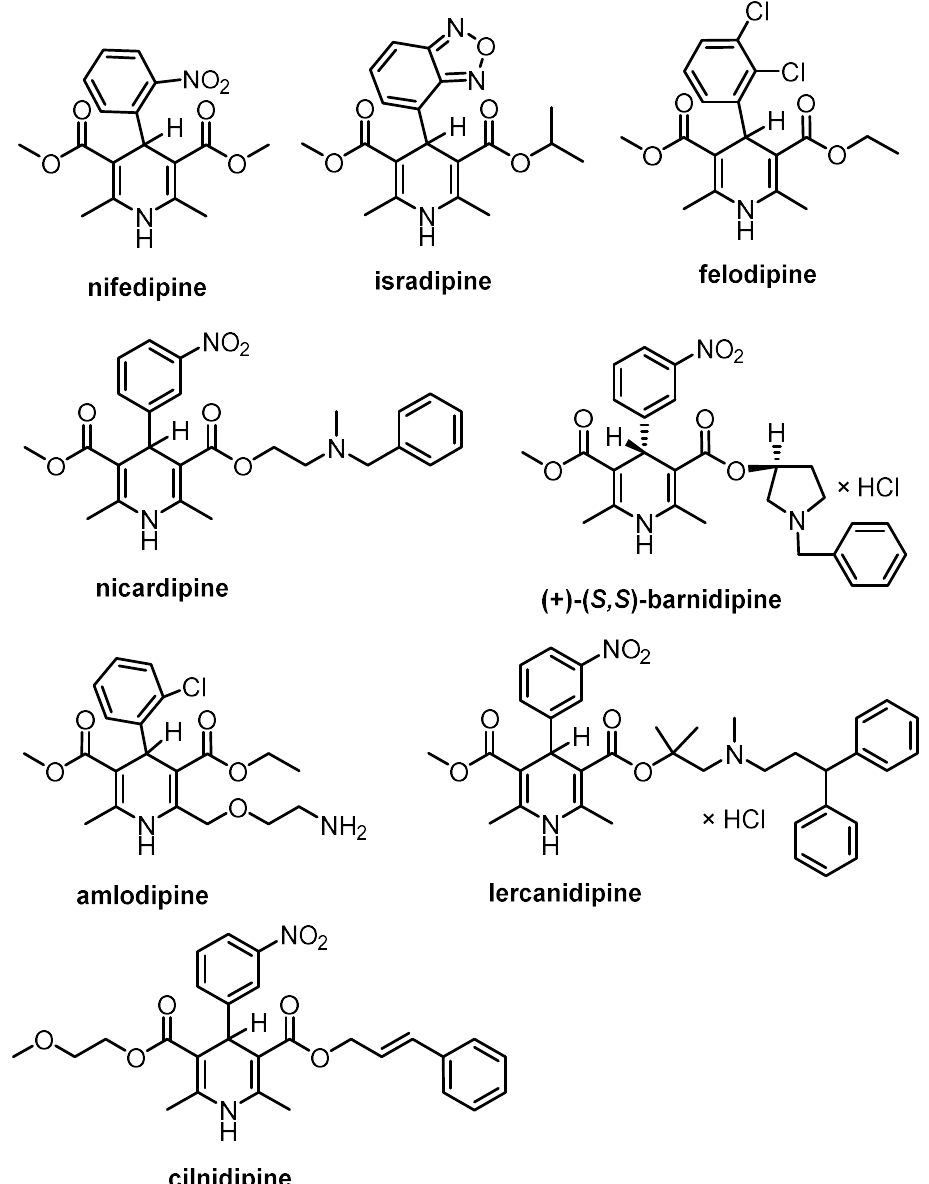
Figure 1. Representatives of 1,4-dihydropyridine calcium channel blockers.